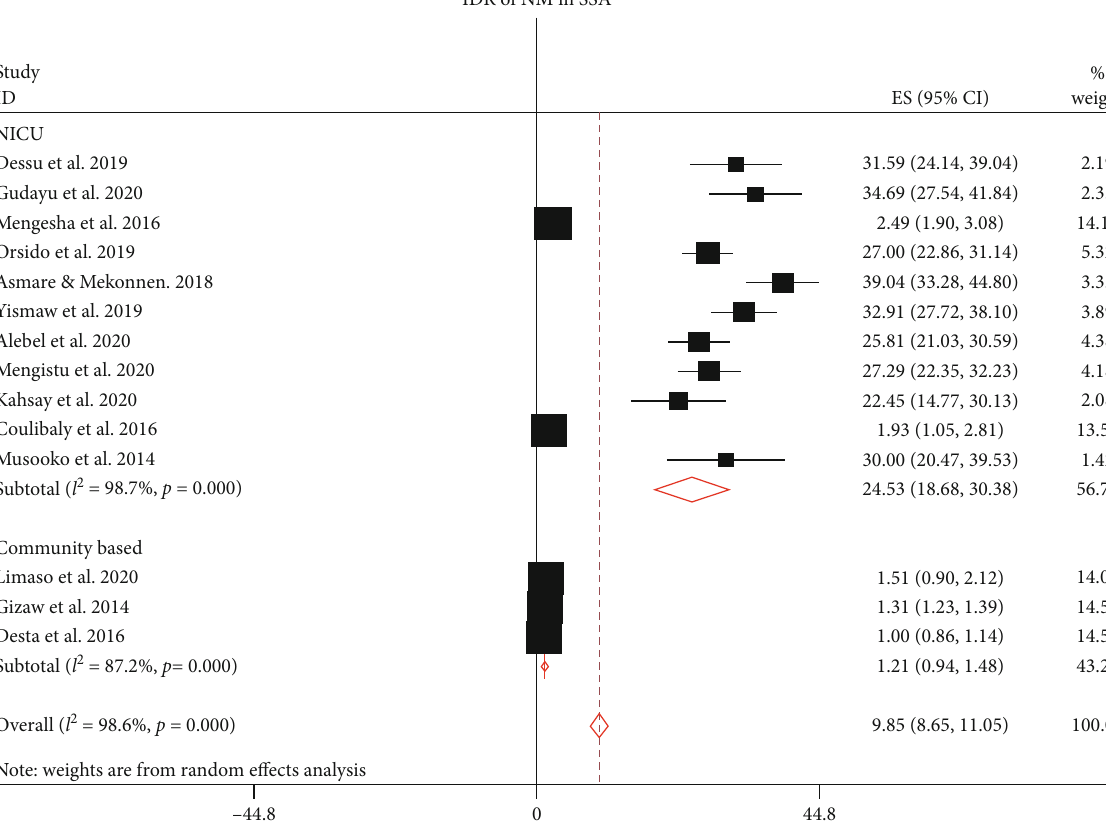
Figure 2: The incidence density rate of neonatal mortality in